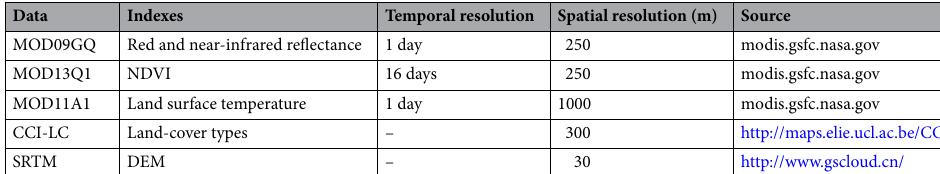
Table 1. Data sources used in the study.